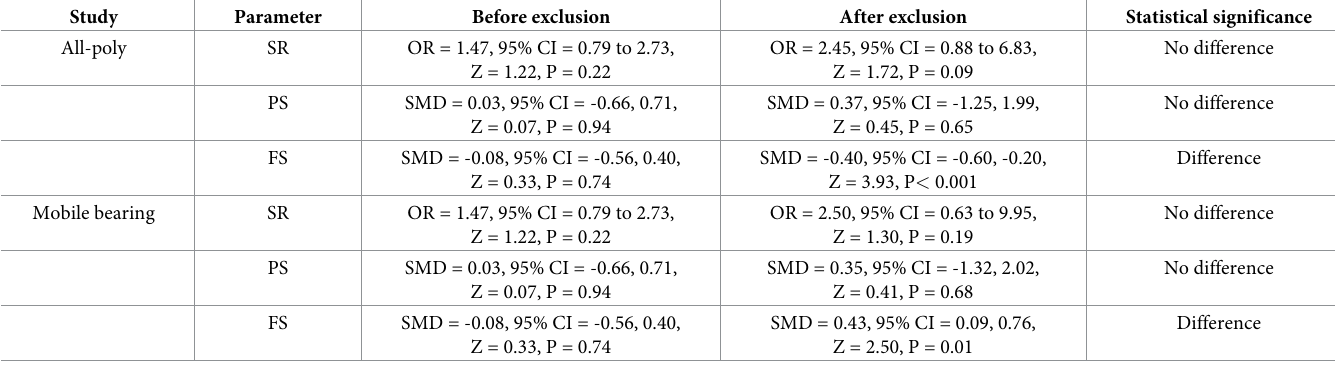
Table 2. Sensitivity analysis.